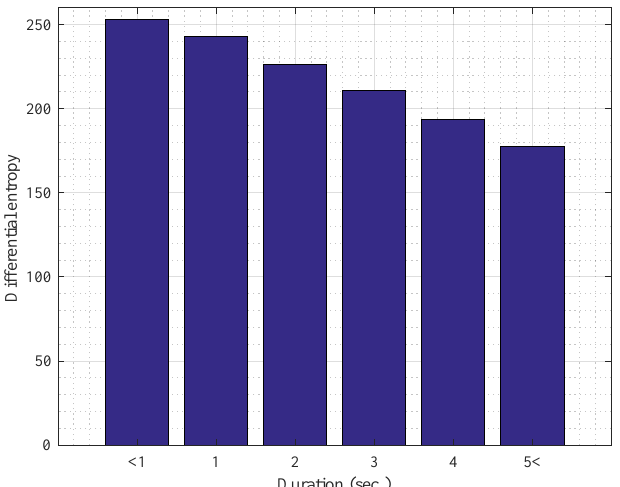
Figure 3. Average differential entropy computed using the latent variable variance extracted from the proposed VAE on different